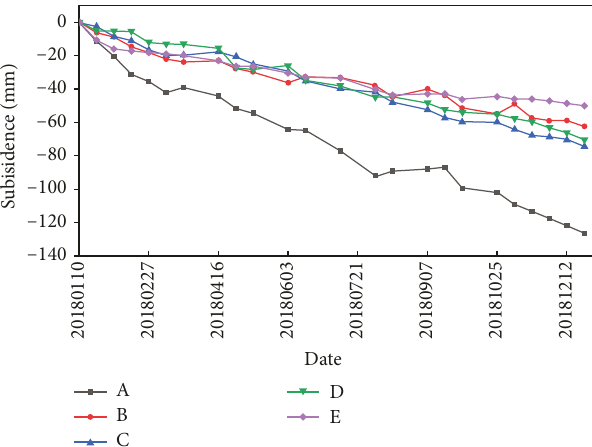
Figure 11: Time series of subsidence at selected